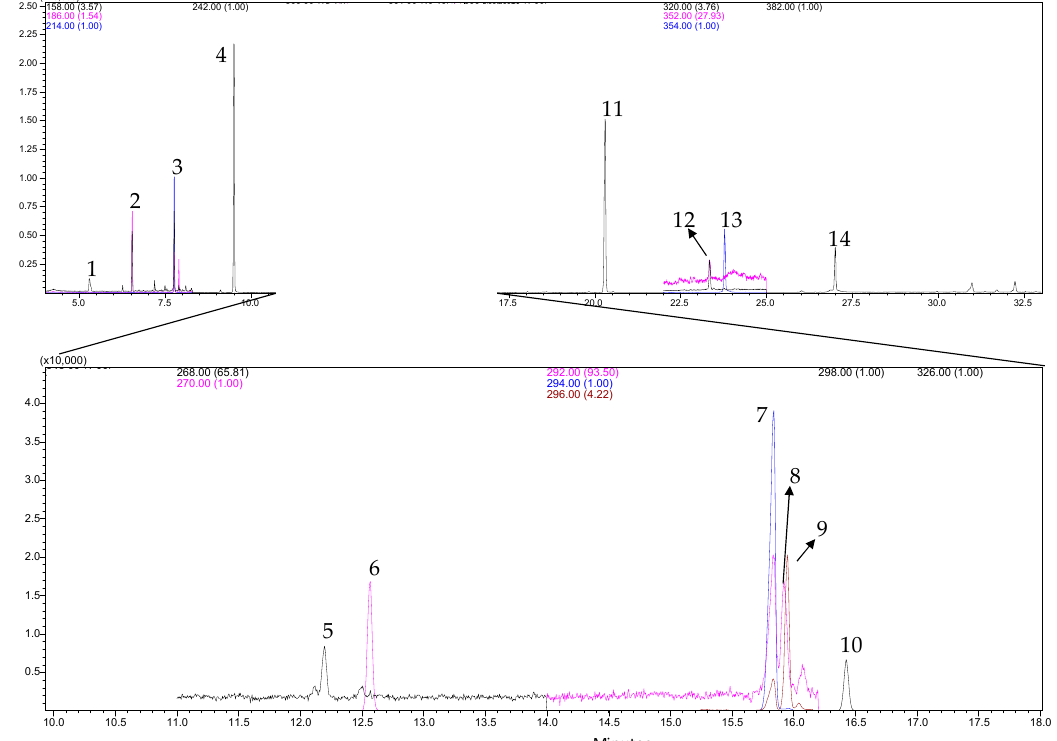
Figure 4. Chromatogram obtained by GC-MS (SIM mode) for the fatty acid profile of grape seed oil using SFE 30:30. Peaks identification: 1—C8:0 (Methyl Octanoate, 5.32 min); 2—C10:0 (Methyl Decanoate, 6.54 min); 3—C12:0 (Methyl Laurate, 7.76 min); 4—C14:0 (Methyl Tetradecanoate, 9.51